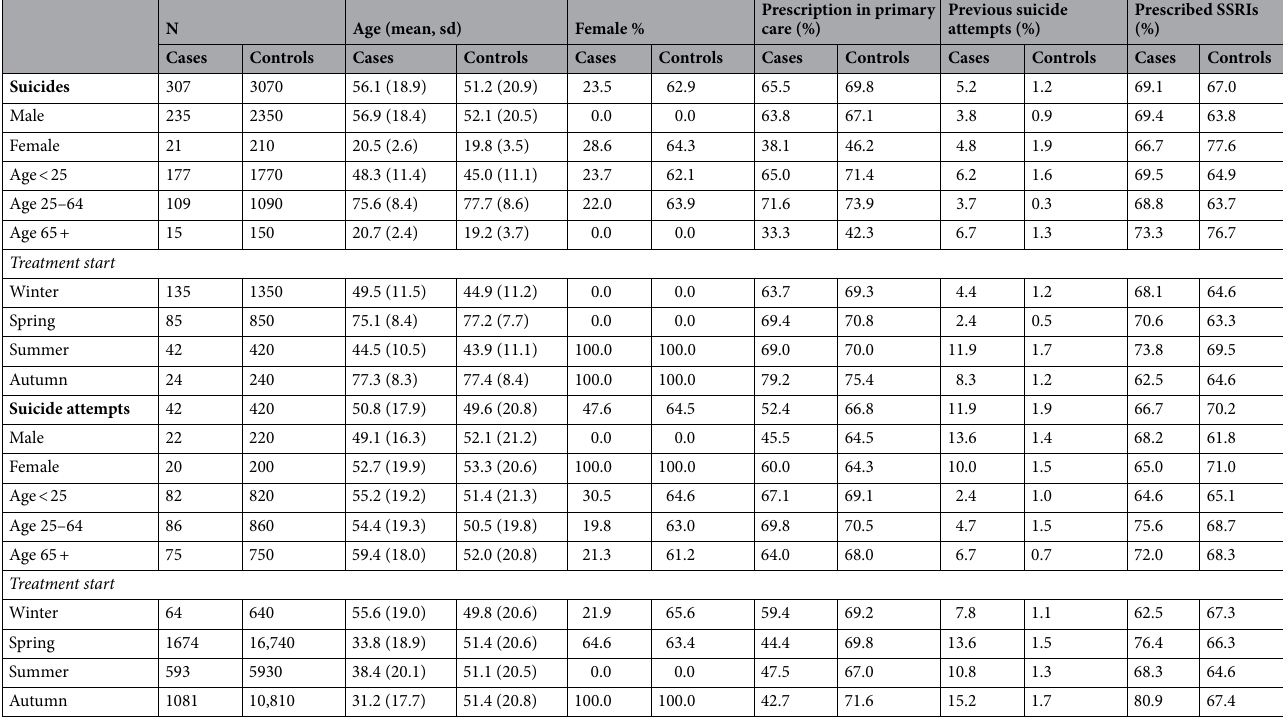
Table 1. The distribution of age, sex, prescription setting, previous suicide attempt and type of antidepressant medication in cases (suicides and suicide-attempts) and controls within different strata. For each case, 10 controls were randomly sampled from the population at